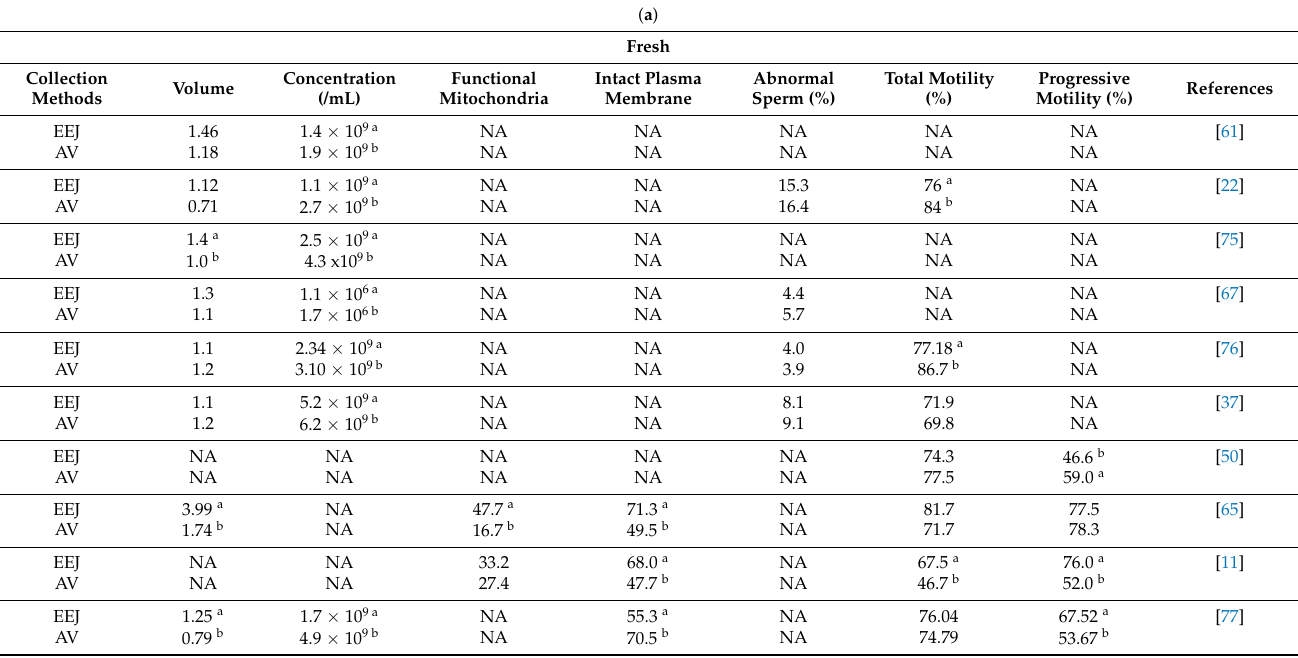
Table 2. ( a ) Effects of collection methods on fresh ram semen’s quality parameters. ( b ) Effects of collection methods on post-thawed ram semen’s quality